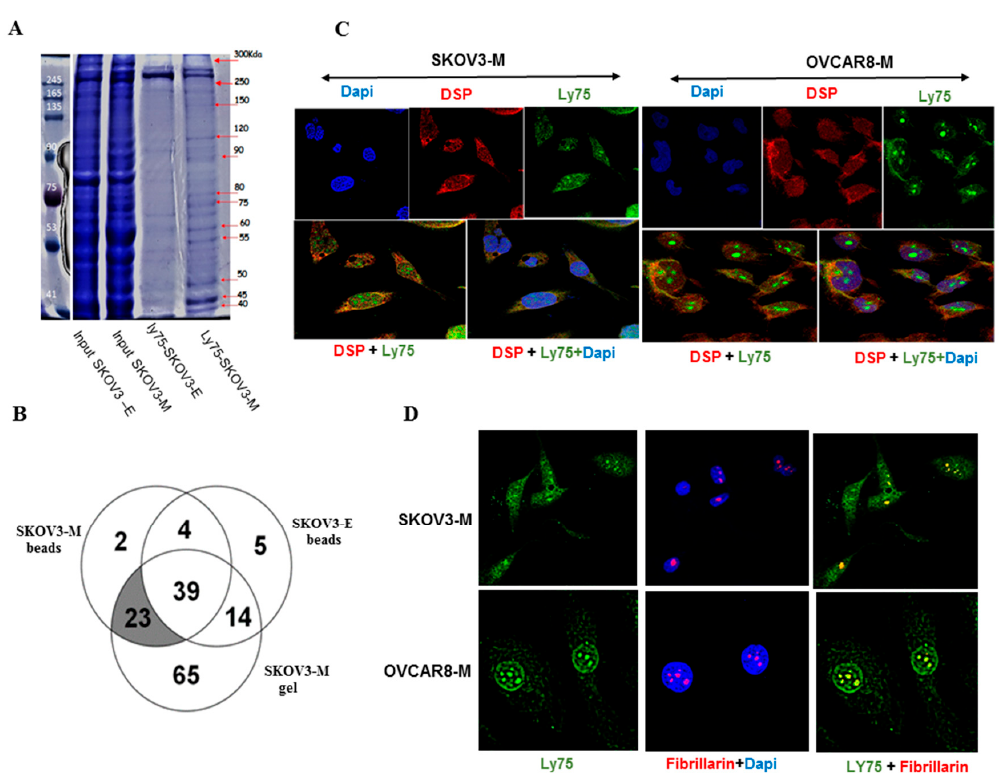
Figure 5. Identification of LY75 interaction partners. ( A ) Gel electrophoresis (Coomassie blue-stained) of anti-LY75 immunoprecipitated protein fractions in SKOV3-E and SKOV-M cells. Bands of interest are indicated by arrows. ( B ) Venn diagram analysis of LY75-interaction proteins identified by LC-MS-MS in SKOV3-M cells, either eluted directly from beads (SKOV3-M beads), or gel-extracted (SKOV3-M gel), compared to nonspecific LY75 interaction proteins extracted from the SKOV3-E (LY75 KD) cells. ( C ) Immunofluorescence analysis of LY75 and DSP cellular co-localization in SKOV3-M and OVCAR8-M cells. The green label is also indicative for a specific nuclear localization of LY75 in both epithelial ovarian cancer (EOC) cell lines. ( D ) Immunofluorescence analysis of LY75 and fibrillarin nucleolar co-localization in SKOV3-M and OVCAR8-M cells.